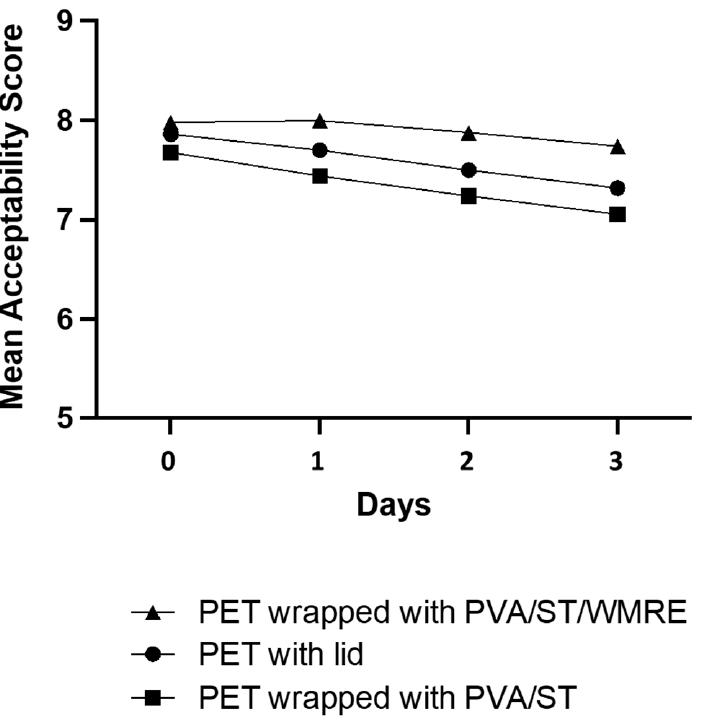
Figure 7. The overall acceptability score of the three different conditions of storage: PET with a lid, PET wrapped with PVA/ST, and PET wrapped with PVA/ST/WMRE while refrigerated at 4 °C, with analysis on 3 consecutive days.